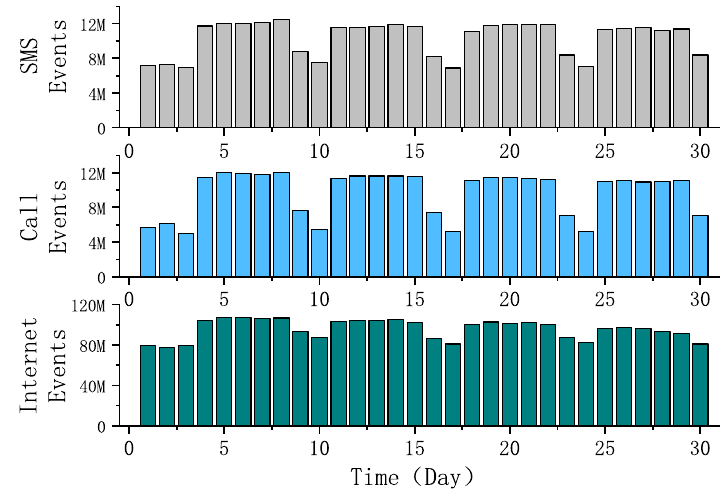
Figure 2. Daily traffic change statistics.